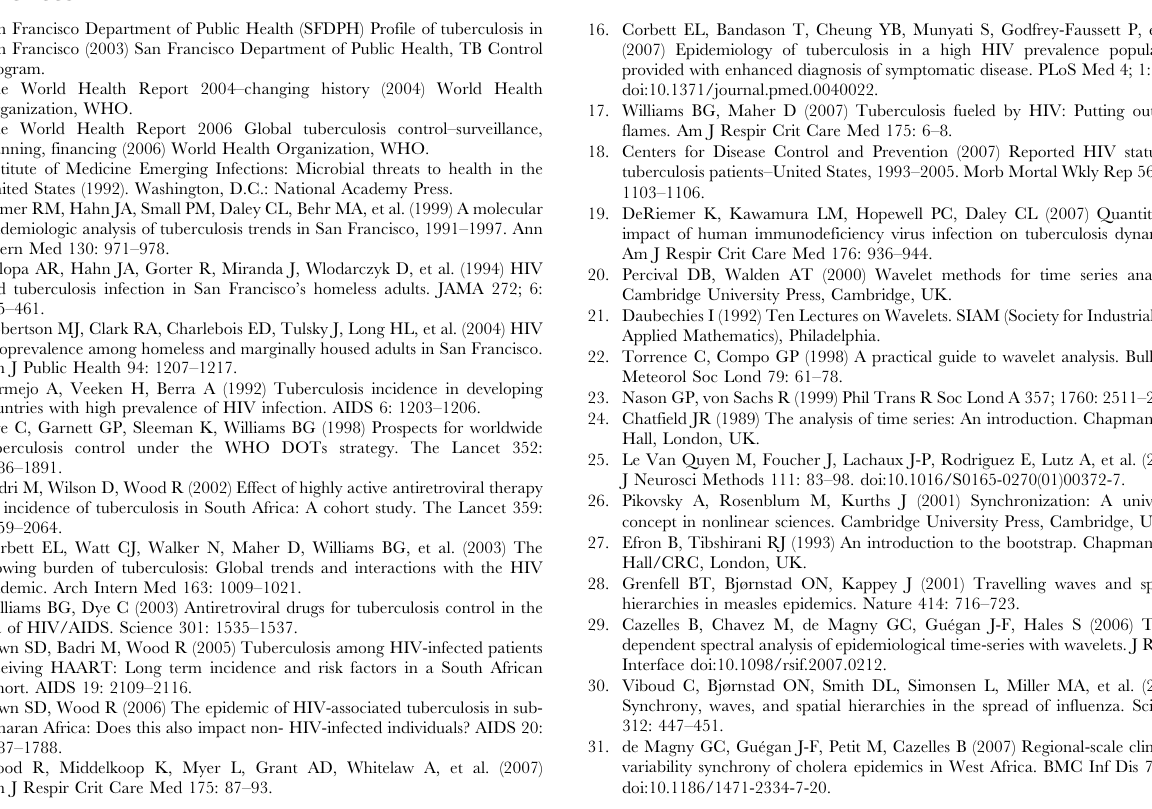
Figure S1 Annual percentage of HIV + TB cases, January 1993- December 2005. (A) Homeless. (B) Non-homeless. The slope of the linear fit (red line) indicates the rate of growth for the homeless (positive value) and the rate of decline for the non-homeless (negative value). Found at: doi:10.1371/journal.pone.0008851.s001 (0.06 MB DOC) Figure S2 Annual percentage of PPD + contacts with missing HIV status, January 1993-December 2005. (A) Homeless. (B) Non- homeless. The slope of the linear fit (red line) indicates the rate of decline for the homeless (negative value) and the rate of growth for the non-homeless (positive value). Found at: doi:10.1371/journal.pone.0008851.s002 (0.06 MB DOC) Found at: doi:10.1371/journal.pone.0008851.s003 (0.07